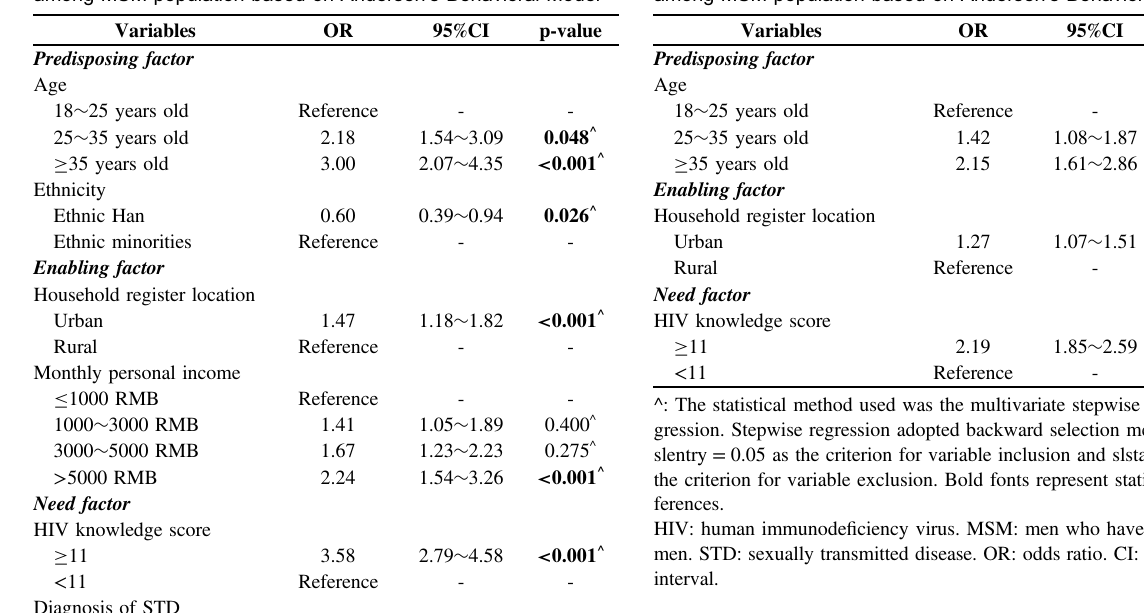
Table 3 Multivariate logistic regression analysis of HIV testing among MSM population based on Andersen ’ s Behavioral Model